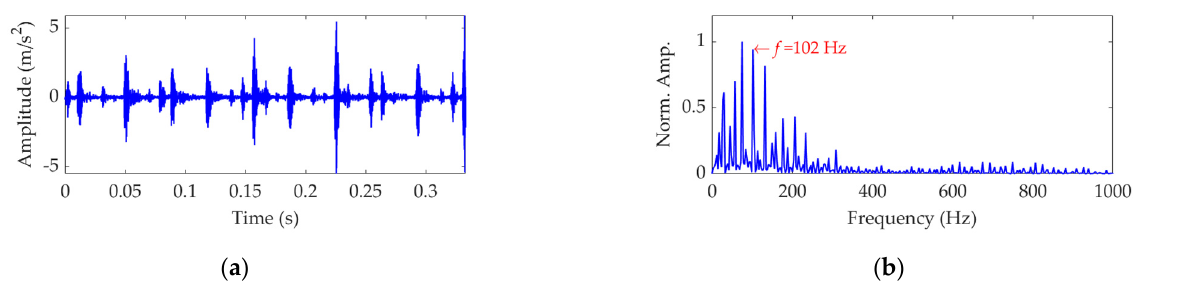
Figure 17. Vibration dataset associated with the outer race fault: ( a ) time − domain waveform and ( b ) SES.